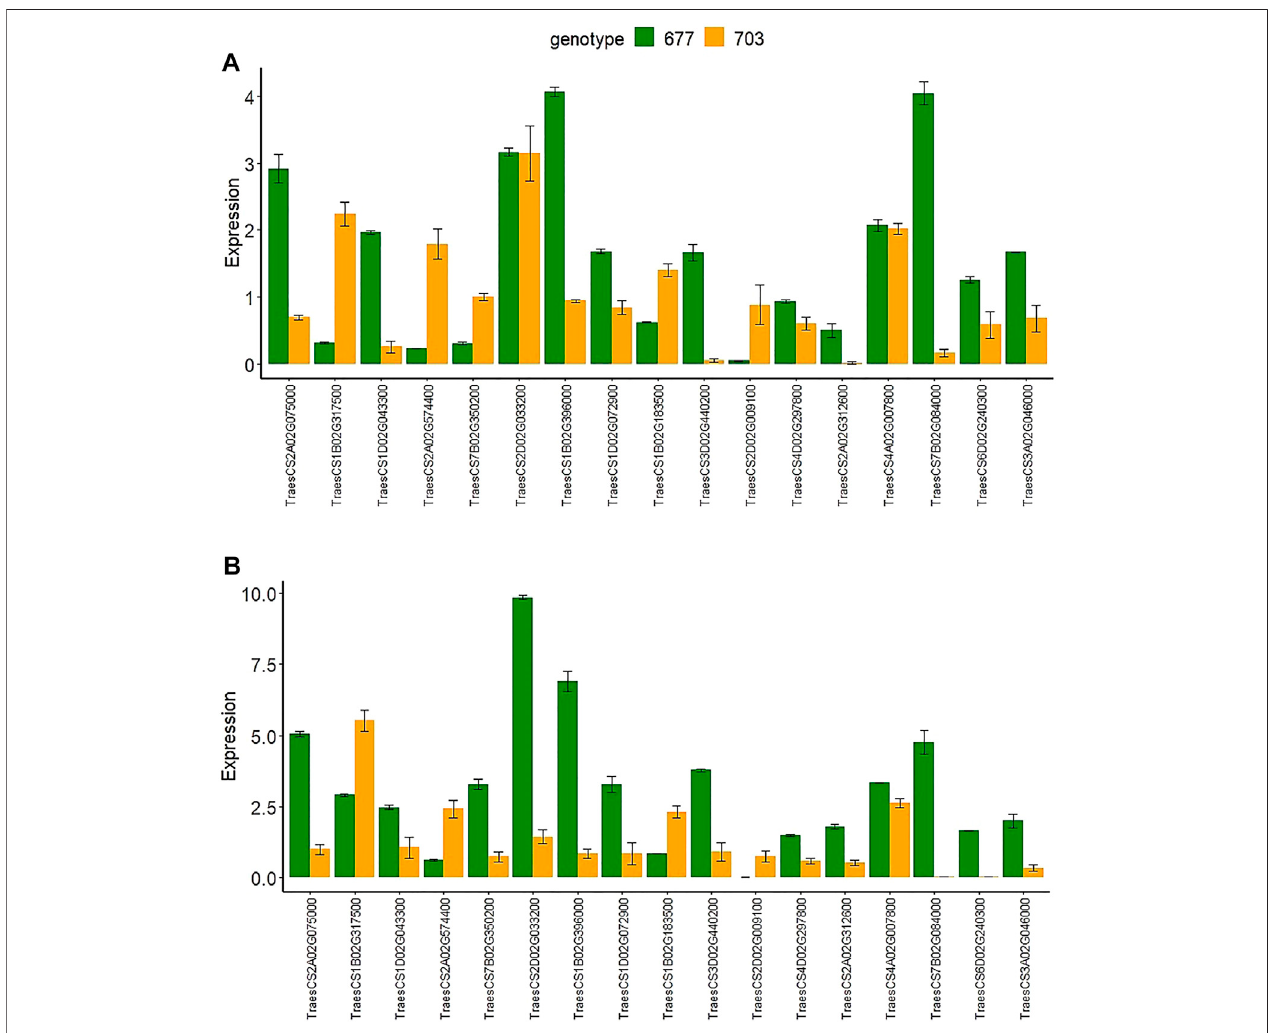
FIGURE 8 | The relative gene expression of 17 randomly selected genes examined by RT-qPCR in both genotypes PBW677 and PBW703 in (A) roots and (B) shoots.